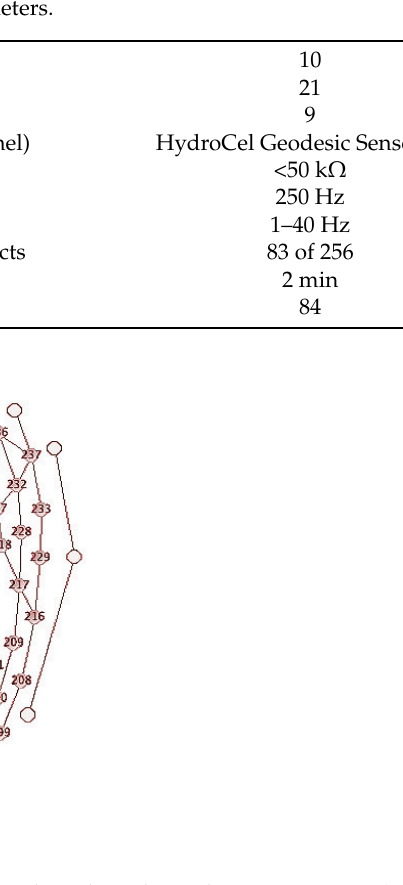
Figure 2. 2D representation of the 256-channel HydroCel Geodesic Sensor Net (HCGSN). The 173 selected electrodes are marked in green. The electrodes marked in red were not considered. Table 2. Number of connected nodes for each group of subjects as a function of the threshold applied to the connection matrices of size m = 84 × 83 = 6972 (self-loops are not taken into